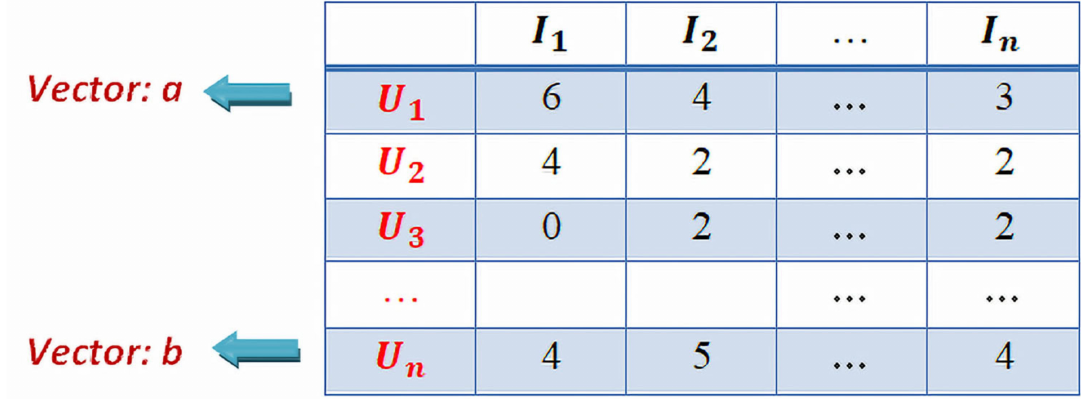
Figure 3. An example of user–user CFL method. Computation of similarity between two users is shown in Figure 4.